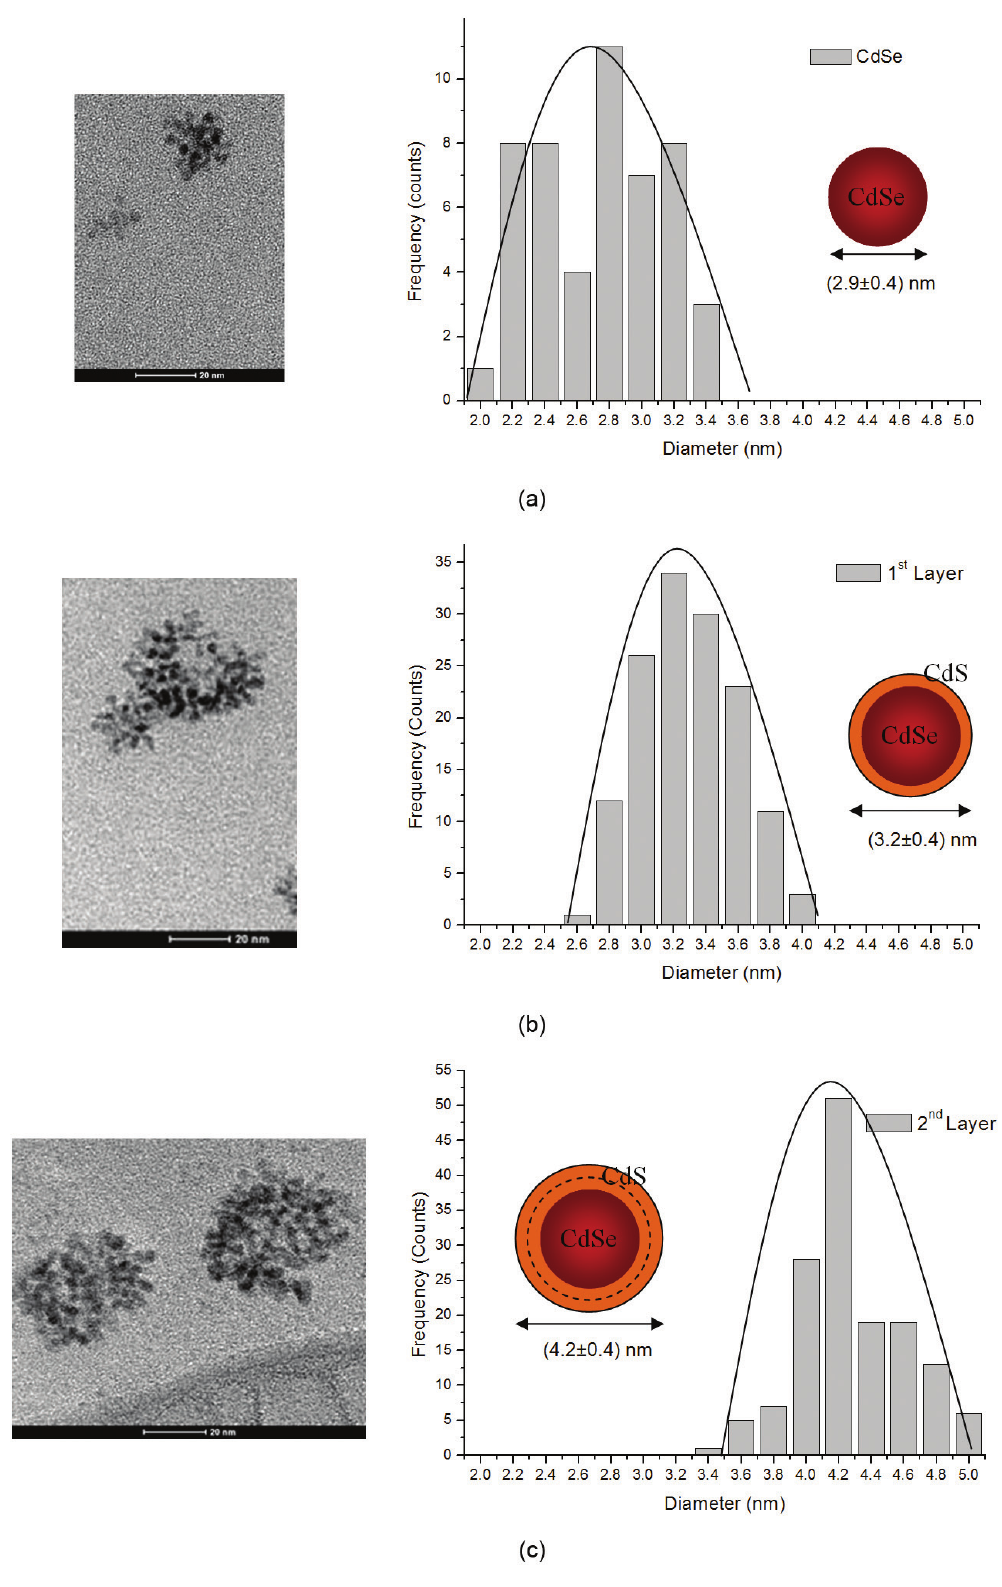
Figure 5. Histogram of the size distributions based on TEM analysis: CdSe core (a), CdSe/CdS – 1 st monolayer (b), and CdSe/CdS – 2 nd monolayer